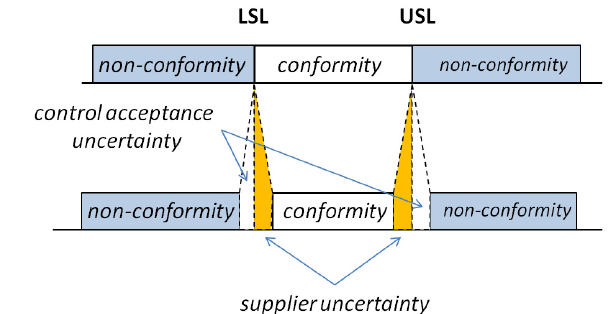
Fig. 1. Acceptance, refusal and ambiguity intervals [7].